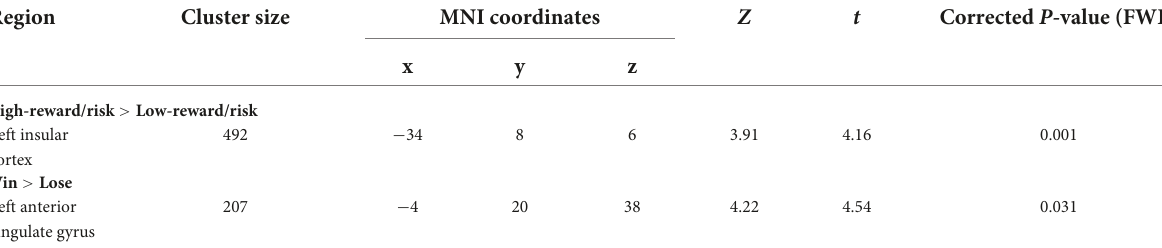
TABLE 4 Summary of SN > SI cluster-level corrected results for two contrasts of interest (IQ as covariate of no interest). Region Cluster size MNI